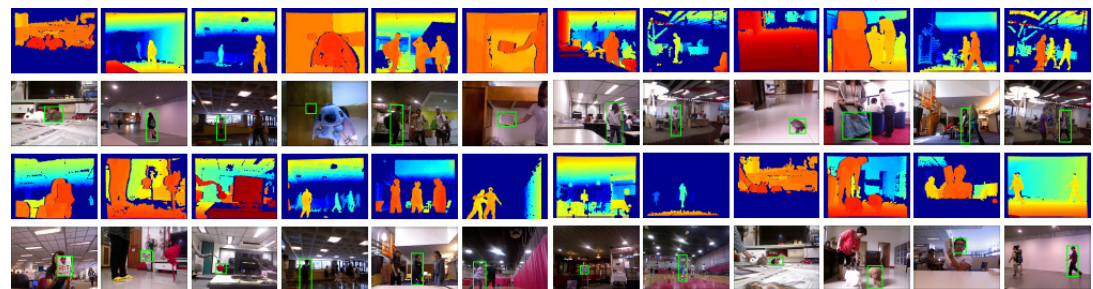
Figure 23. Contents from the RGB-D Human Tracking Dataset. The figure is originally from the RGB-D Human Tracking Dataset website